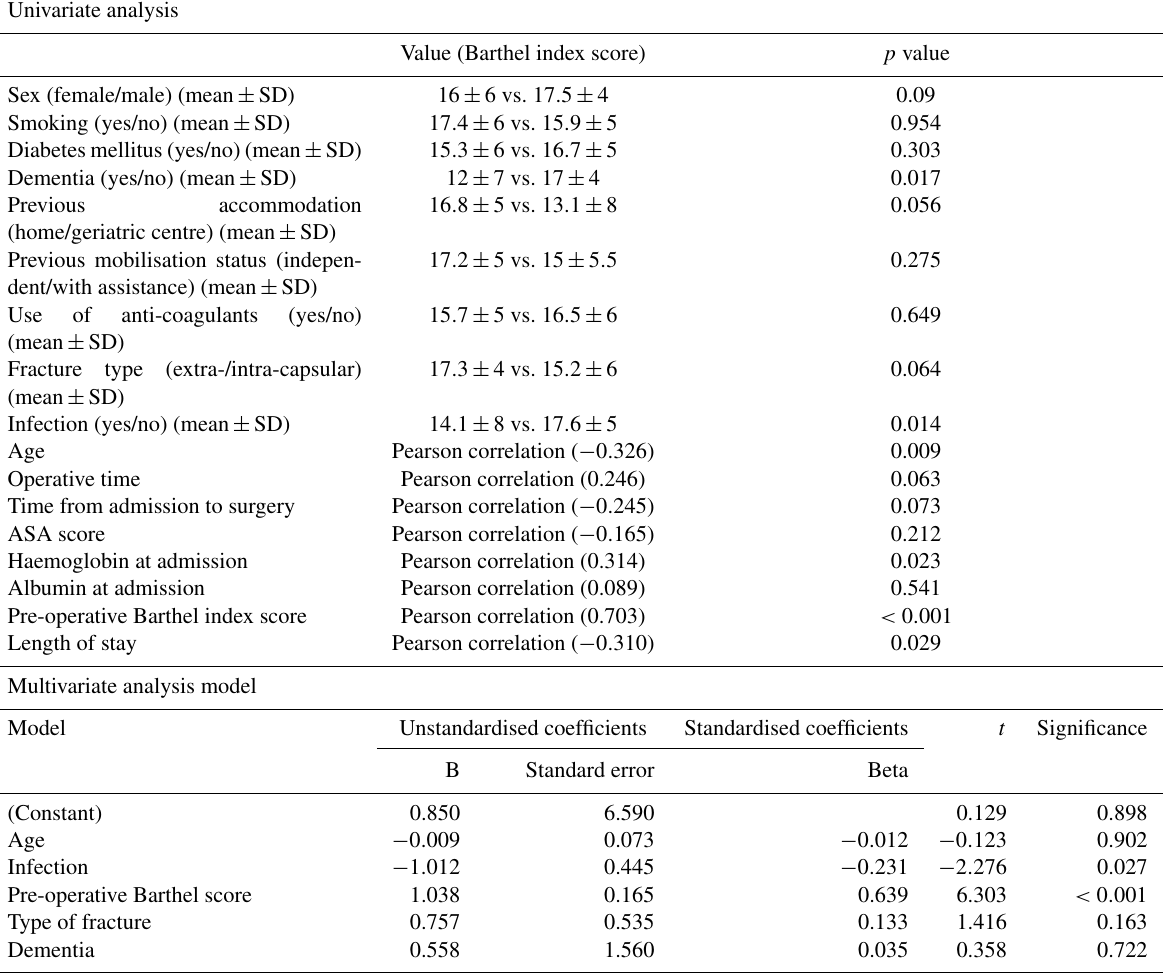
Table 4. List of variables tested in the model regarding the final Barthel index score. Variables with statistically significant correlations or differences were entered in the multiple regression